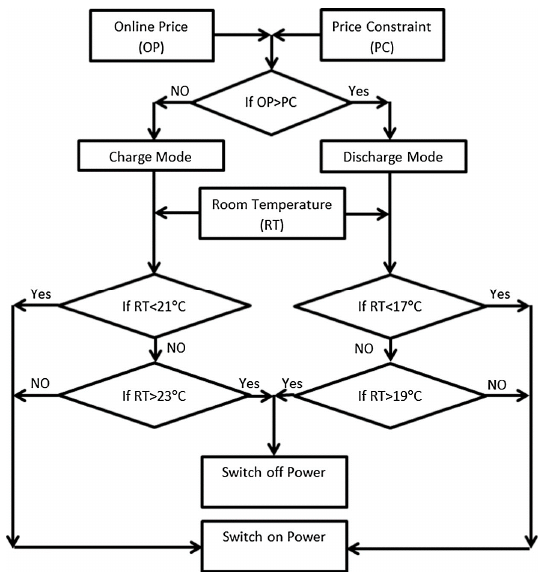
Figure 6. The control strategy applied to the huts of the University of Auckland for passive space heating [93].